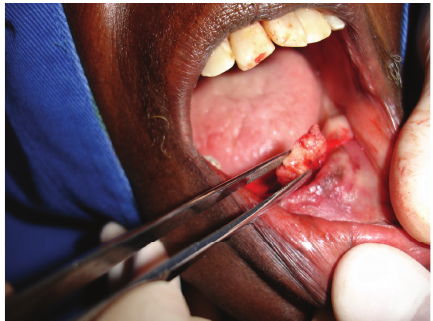
Figure 2: Surgical removal of bone